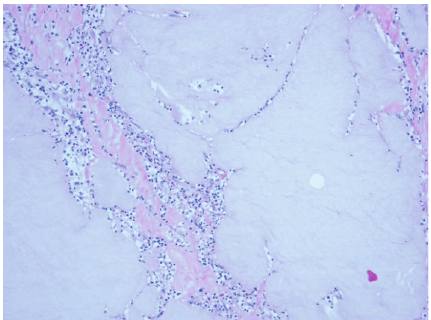
Figure 2: Amorphous eosinophilic material resembling amyloid e ff acing submucosal connective tissue. H and E stain × 20.